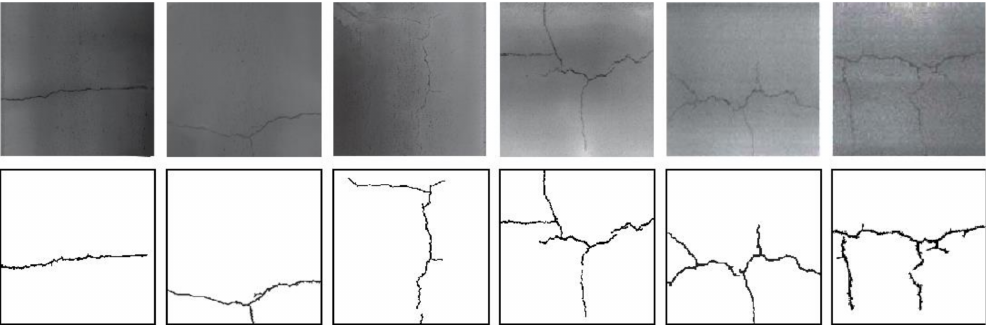
Figure 8. Segmentation of concrete cracks by the UHK-Net network model.